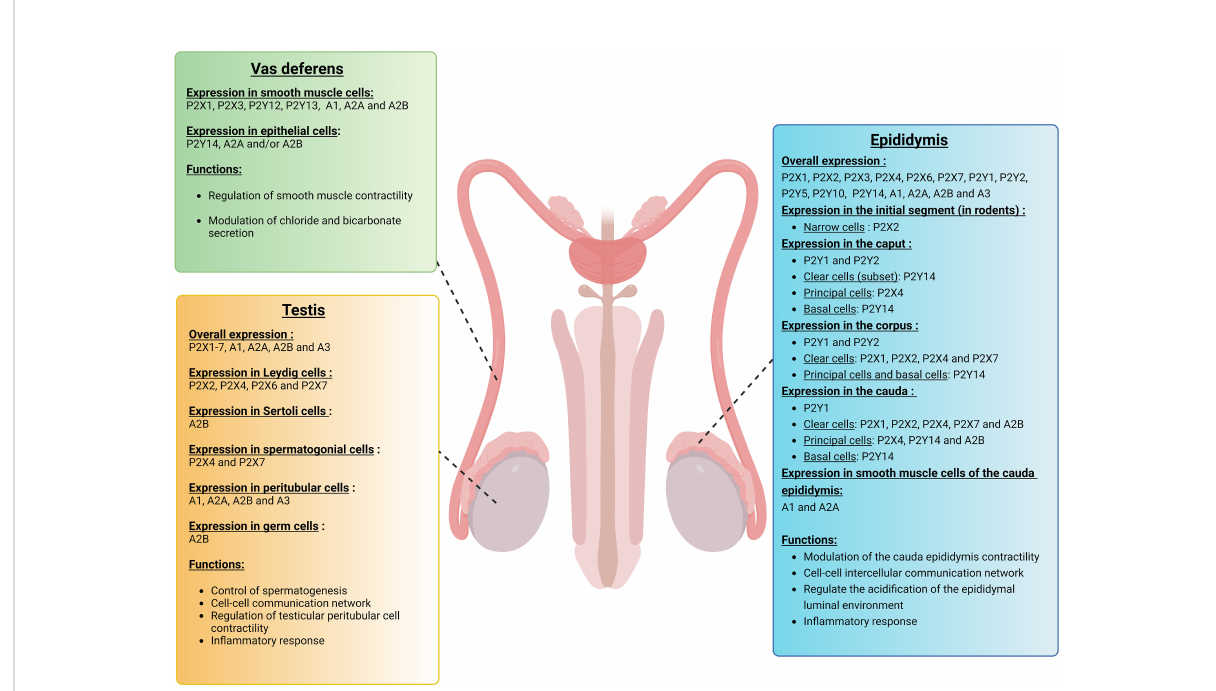
FIGURE 3 Expression of purinergic receptors in vas deferens, testis, and epididymis. Different sets of purinergic receptors belonging to the P1, P2X, and P2Y families are expressed in the vas deferens, testis, and epididymis. These receptors are involved in various cell functions, including smooth muscle contraction, vasodilatation, transepithelial transport as well as in fl ammation, and thus play a role in the establishment of male fertility. In the vas deferens, purinergic signaling mostly participates in the regulation of smooth muscle contraction and quality of the semen. In the testis, various purinergic receptors are expressed in a cell-speci fi c manner, including Leydig cells, Sertoli cells, spermatogonial cells, testicular peritubular cells, and germ cells. These purinergic receptors play a critical role in testicular autocrine and paracrine communication. In the epididymis, different subtypes of purinergic receptors are expressed in a cell-speci fi c and segment-speci fi c manner. Purinergic signaling in the epididymis is part of a complex intercellular communication network that leads to the establishment of an optimal acidic extracellular